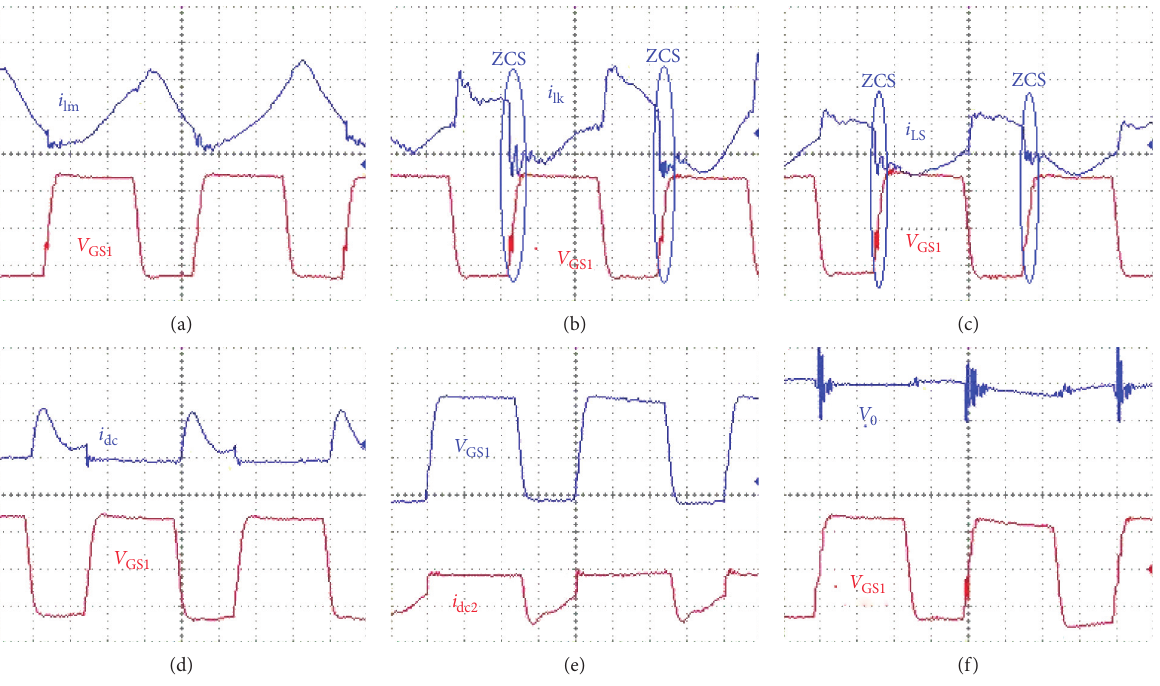
Figure 11: SISO (boost) mode results (scale: 5 V/DIV, 2A/DIV, and 2.5 us/DIV). (a) Gate signal V waveforms. (b) Gate signal V and leakage current i GS1 signal V and diode D current i waveforms. (e) Gate signal V GS1 c dc voltage V 0